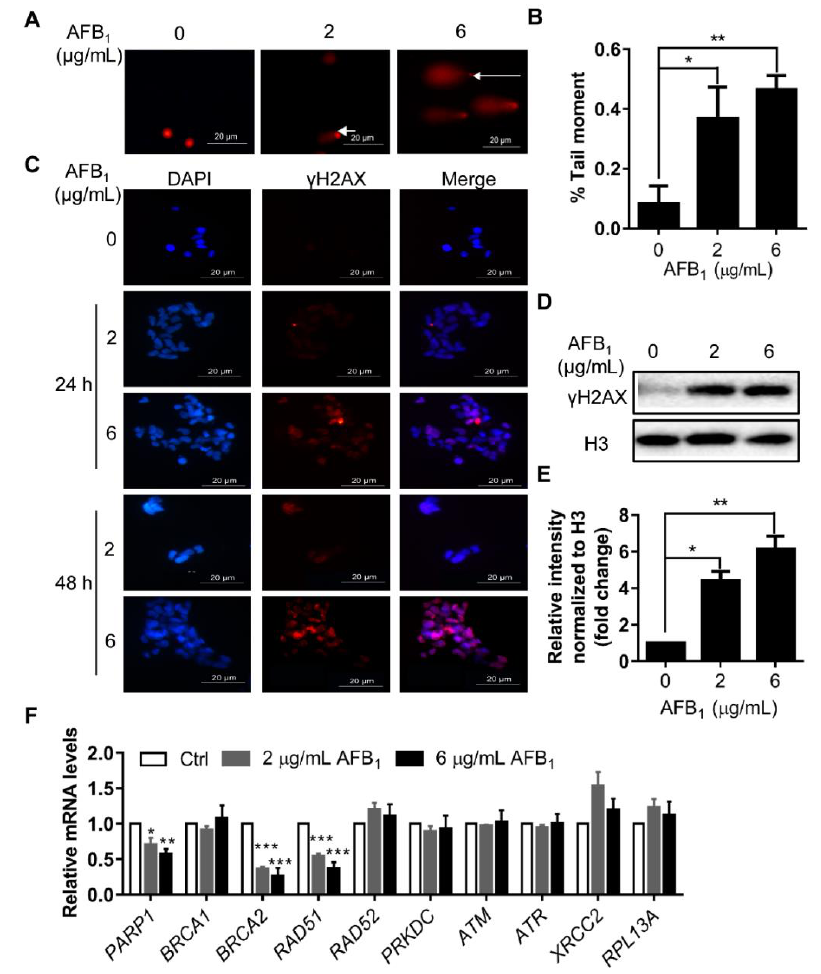
Figure 4. AFB 1 induces DNA damage and inhibits transcription of DNA damage response genes in IMR-32 cells. ( A ) A comet assay was used to detect DNA damage after treatment with different concentrations of AFB 1 (2 µ g / mL and 6 µ g / mL) for 24 h. White arrows indicate tail DNA. ( B ) Quantification of the tail moment in panel A by ImageJ. ( C ) Representative immunofluorescence staining image of γ H2AX in IMR-32 cells after 2 or 6 µ g / mL AFB 1 treatment for 24 h and 48 h. Blue colour: nucleus; Red colour: γ H2AX; ( D ) Representative Western blot of γ H2AX in IMR-32